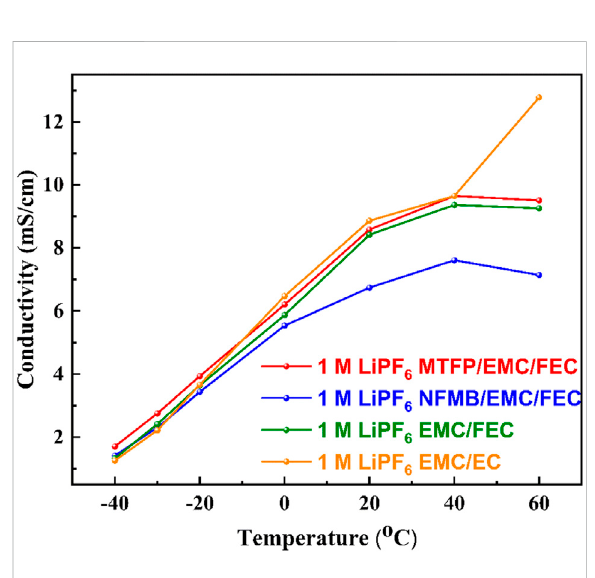
FIGURE 2 Ionic conductivity of different electrolytes in thetemperature range of ‒ 40 – 60 ° C.